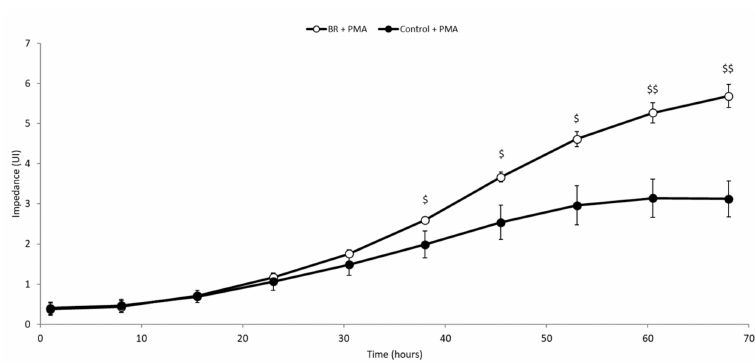
Figure 3. BRE promoted the di ff erentiation of THP-1 cells. Cells were incubated with BRE (50 µ g / mL) and stimulated with PMA (16.2 nM) for 70 h. $ p < 0.05 compared with PMA-stimulated cells, $$ p < 0.01 compared with PMA-stimulated